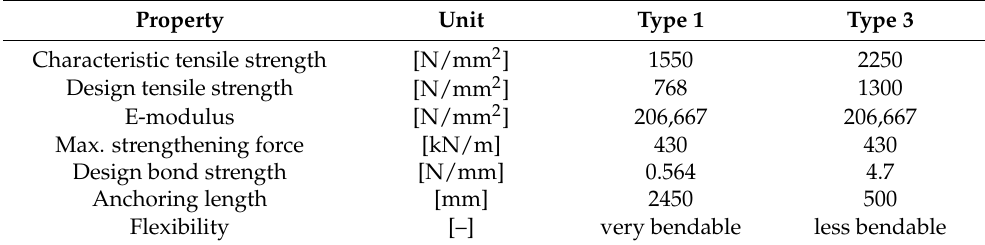
Table 3. Mechanical properties of the different CARBOrefit ® -grids, according to [30]. Property